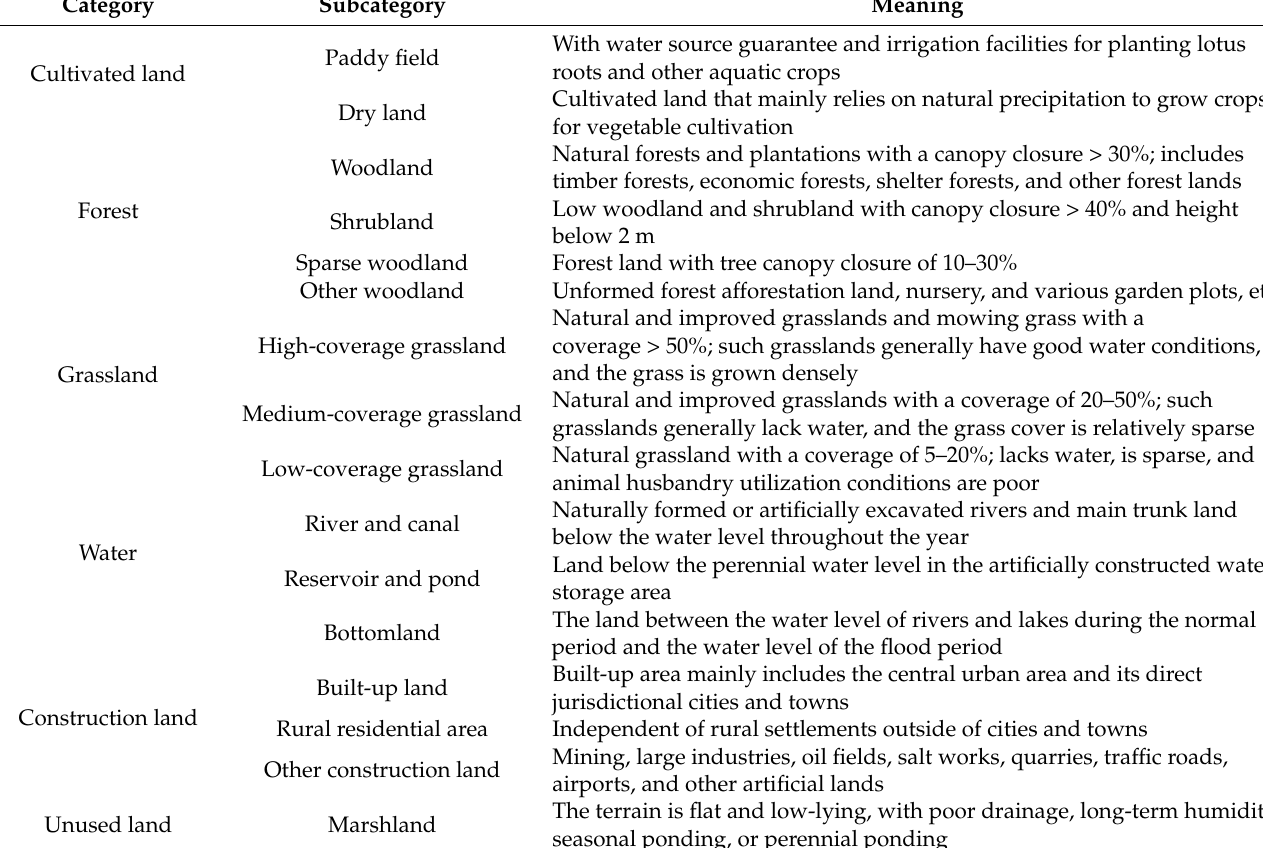
Table A1. Classification system of remote sensing monitoring data of LUCC in Zhengzhou.